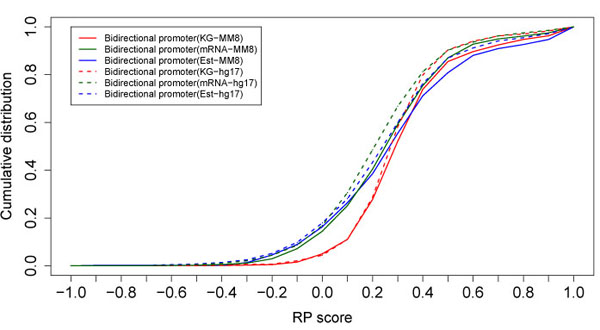
RP score cumulative distribution functions for bidirectional promoters in human and mouse. Bidirectional promoters identified from Known Genes (KG), mRNA, and ESTs all yield similar scores in both human and mouse genomes. RP scores were calculated based on genome assemblies hg17 (human) and mm8 (mouse).